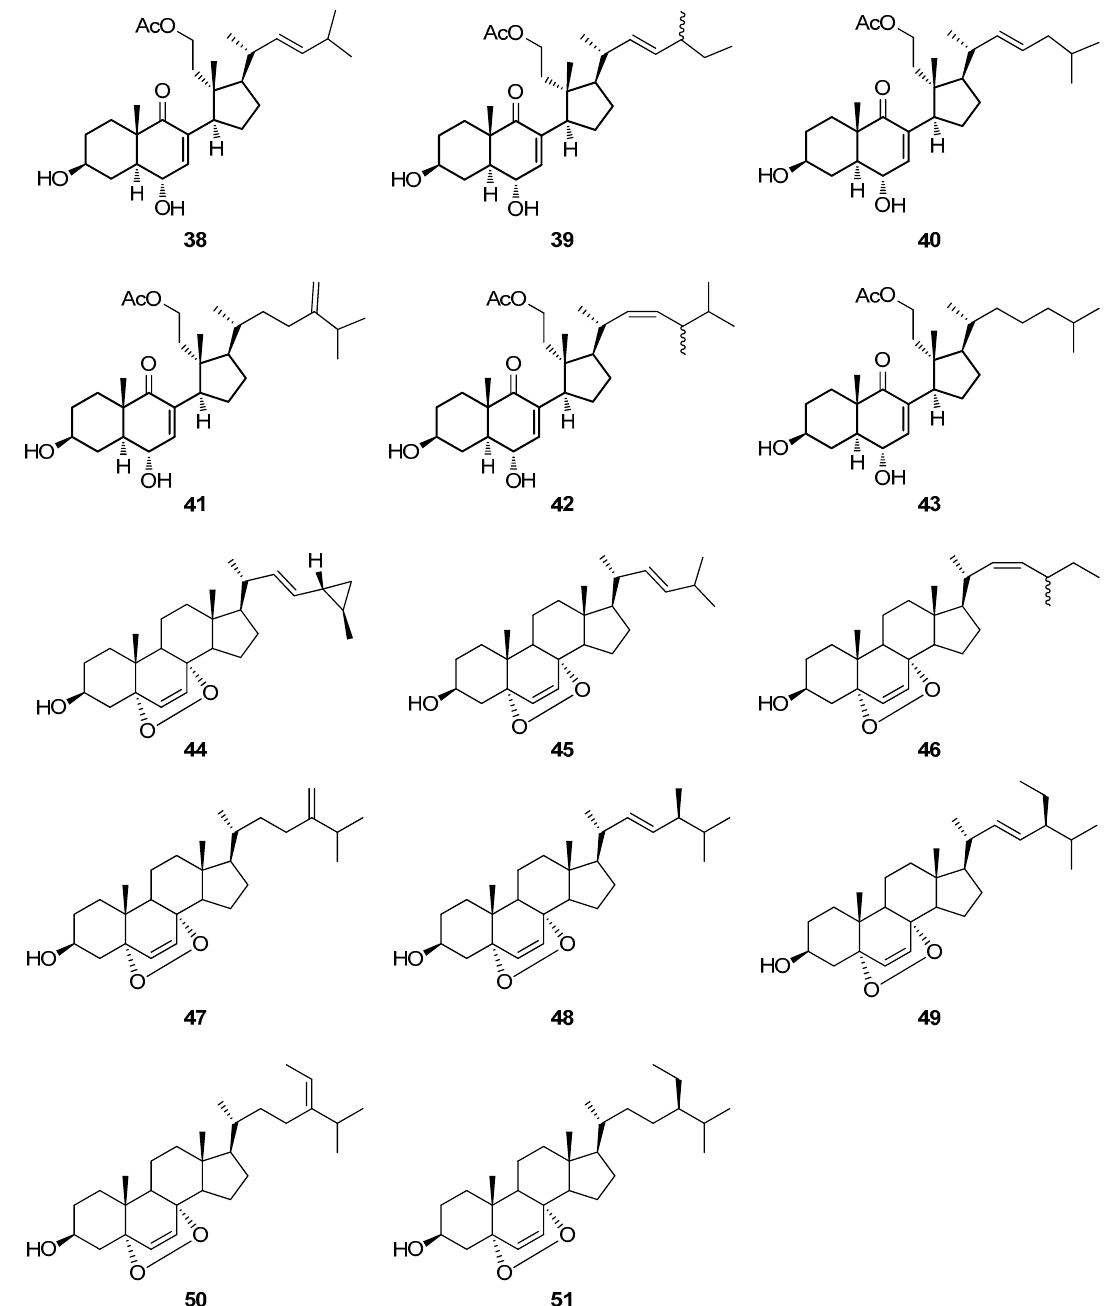
Figure 11. Structures of nine 11-secosterols ( 38 – 43 ) and 5 α ,8 α -epidioxysterols ( 44 – 51 ).